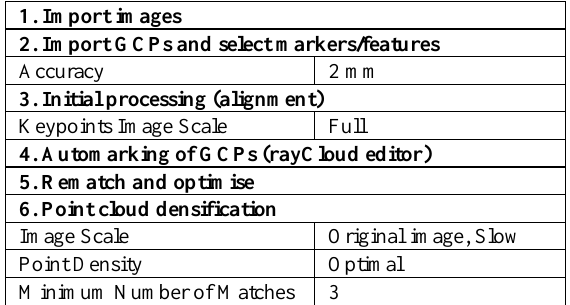
Table 4. General workflow and main parameters used with